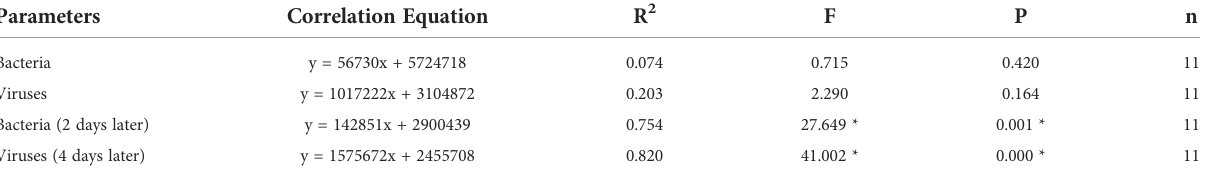
TABLE 4 Correlation analysis between bacteria, viruses, and Chl-a.